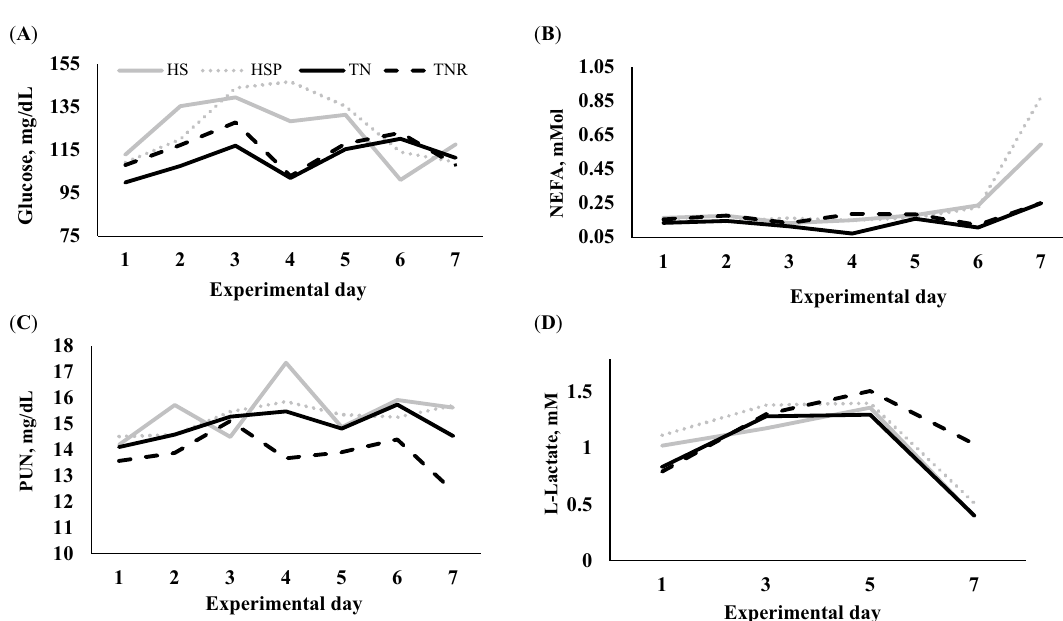
Figure 3. ( A ) HS and HSP treatments increased plasma glucose concentrations (treatment by day interaction; P < 0.005; SEM = 7.47 mg/dL; TN thermoneutral, TNR thermoneutral feed-restricted, HS heat stress, HSP heat stress and dietary supplementation with 3 g of AO postbiotic; n = 8 Holstein bull calves per treatment). ( B ) HS and HSP treatments increased plasma NEFA concentrations (treatment by day interaction; P < 0.033; SEM = 0.021 mM). ( C ) The TNR treatment decreased plasma PUN concentrations (13.8 mg/dL) relative to HS, HSP, and TN ( P ≤ 0.007). ( D ) Plasma l-lactate concentrations were not affected by treatments (SEM = 0.07